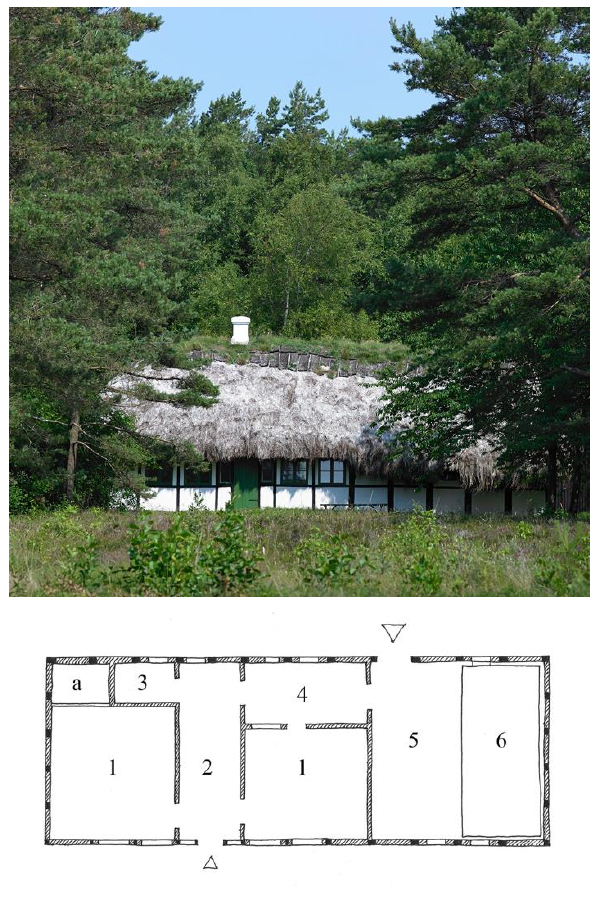
Figure 3. Layout of Kaline’s House after the architectural conservation. Living rooms (1), kitchen (2), larder (3), scullery (4), outbuilding (5), new ‘box’ containing bath and bed recess (6) and bed recess (a). (Drawing by the